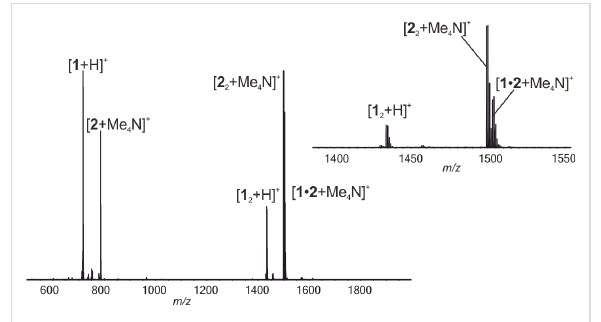
Figure 2: (+)ESI-MS profile spectrum of the mixture of 1 , 2 and TMAPF 6 in acetonitrile (20 µM, 1:1:1). Inset shows a zoom in for region showing dimeric ions.